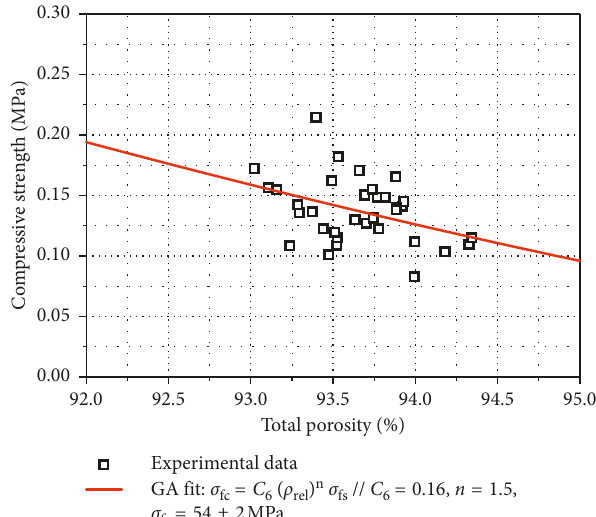
Figure 8: Compressive strength data of 20 ppi ZnO foams ( □ ) and the corresponding fit with the Gibson–Ashby model for the strength-porosity correlation (red